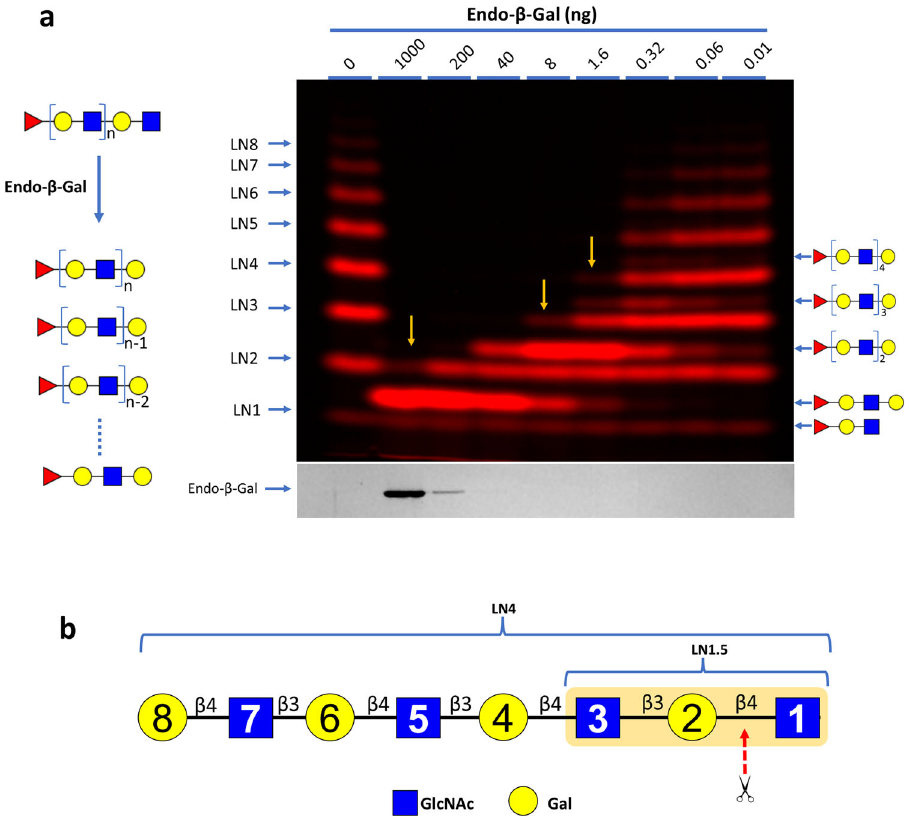
Fig. 7 Endo- β -Gal Assay on Cy5-Fuc labeled polylactosamine ladder (FPLN) and its substrate recognition motif. a Endo- β -Gal Assay on FPLN. FPLN contained 1 to 8 lactosamine (LN) repeats and are indicated as LN1 to LN8. The structures of the products of these reactions are shown at the right side. It is notable that 1.6 ng Endo- β -Gal digested LN4 to a similar degree that required 8 ng of the enzyme on LN3 and 1000 ng of the enzyme towards LN2 (indicated with arrows in the image). In each reaction, 10 pmol of FPLN was digested with indicated amount of Endo- β -Gal in 20 μ l MES buffer pH 6.0 for 120 min at 37 °C and then separated on 15% gel. Both the glycan image and the protein image are shown. Scheme for FPLN digestion by Endo- β -Gal is shown in left. b Likely substrate recognition motif of Endo- β -Gal. Proposed optimal Endo- β -Gal recognition motif is LN4 that spans from residue 1 to 8. The minimal recognition sequence is LN1.5 that contains residue 1 to 3